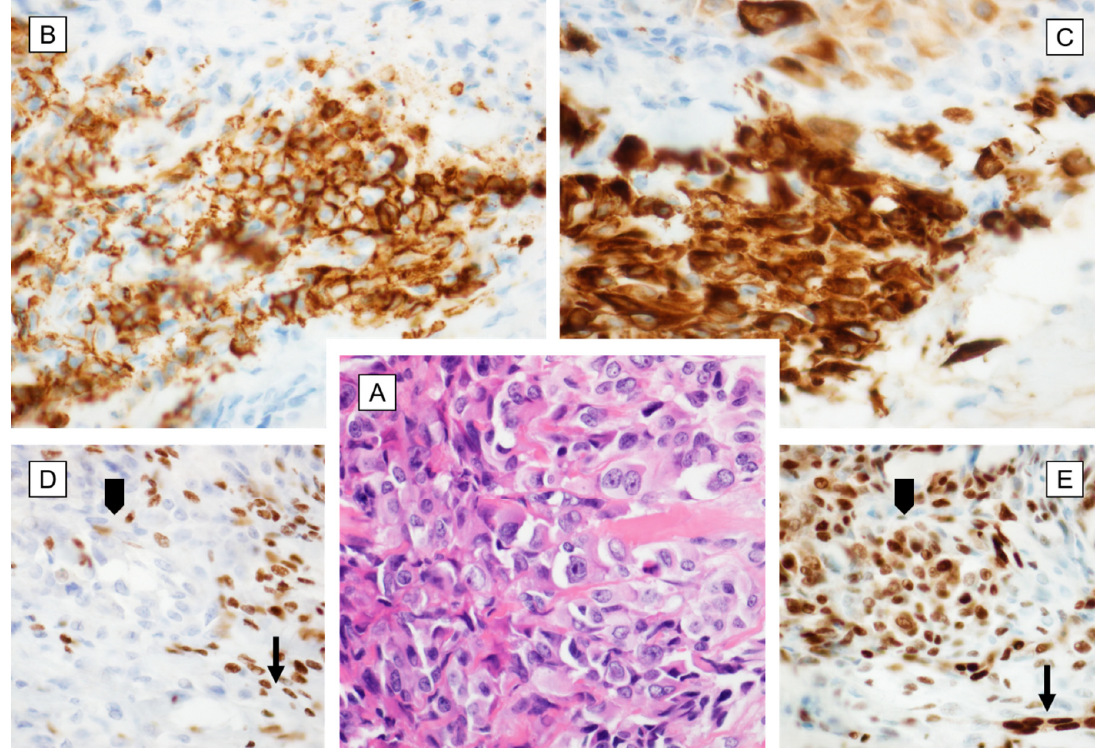
Figure 3. Epithelioid sarcoma—morphology and immune profile. ( A ) Epitheliod, large cells